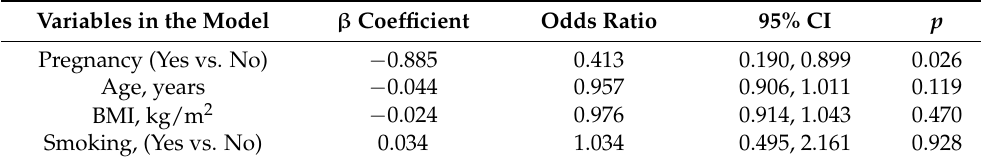
Table 2. Multiple logistic regression analysis of the association between levels of anti-PT IgG antibody (GMC) with pregnancy status, age, BMI, and smoking.